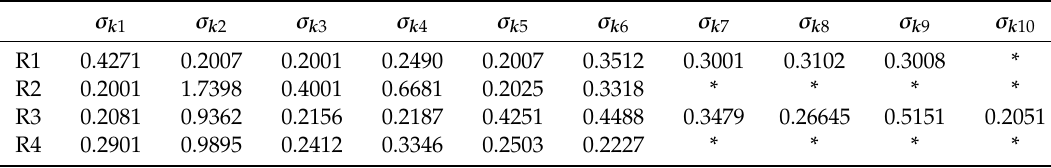
Table 2. Mach number membership σ ki ( Ma ) .